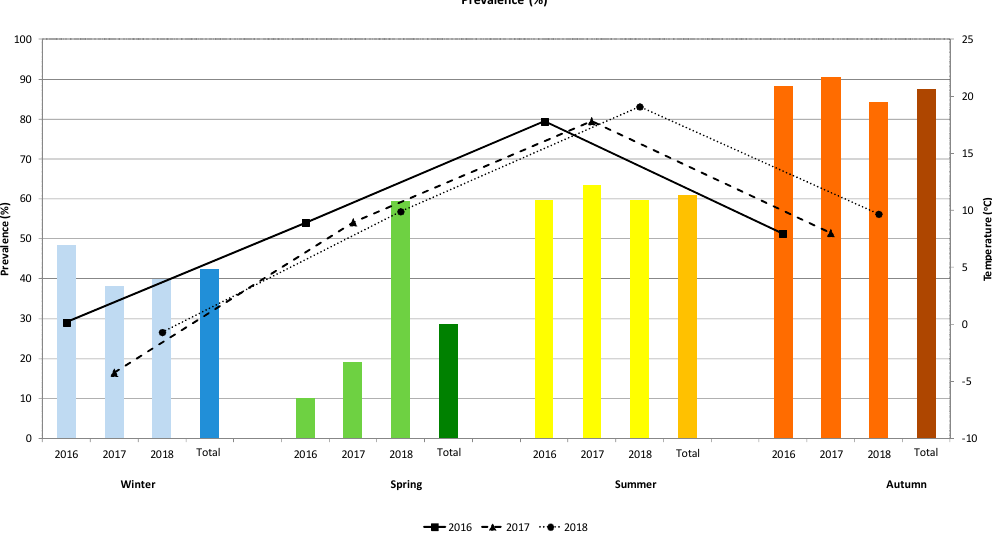
Figure 2. Prevalence of eggs of the nematode B. transfuga in the faecal samples of the brown bear ( Ursus arctos ) and mean temperature (°C) during different seasons of the three-year survey.